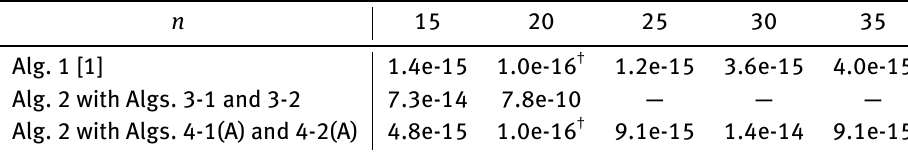
Table 6: Relative errors between the approximate minimum singular value of T in Table 4 and the minimum singular value of T computed by svd . The superscript † indicates that the relative error in (20) equals